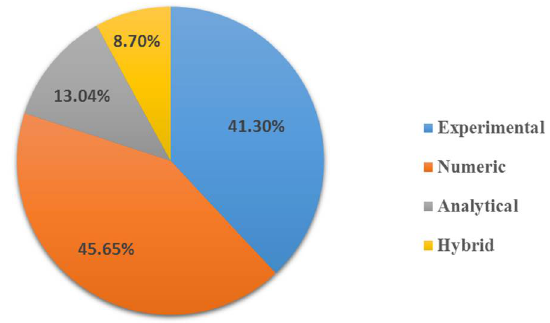
Figure 8. Types of study methods used in the sample.